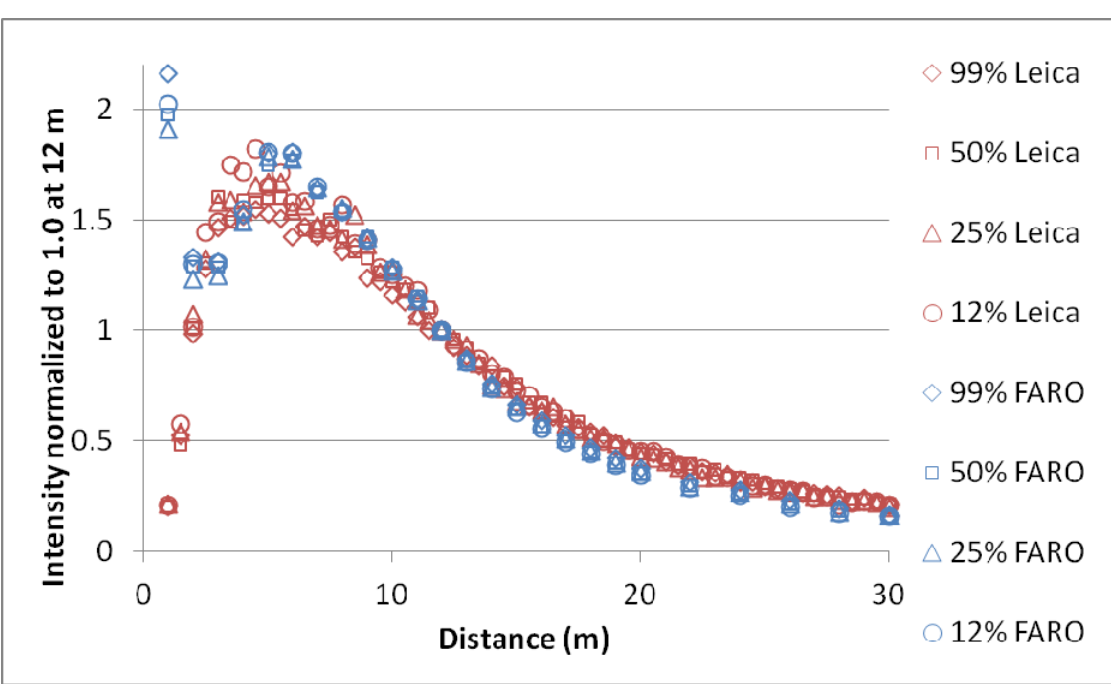
Figure 1. Intensity vs. range for FARO LS880 and Leica HDS 6100 scanners for the 4-step ® target, normalized to equal 1.0 at 12 m. The measurement errors (typically Spectralon 1%–5%) are approximately the same size as the plot symbols. Up to 10 m, the values do not follow the 1/R 2 prediction (Equation (2)). The large values near 0 m distance are caused by system noise always present at near-distance measurements.